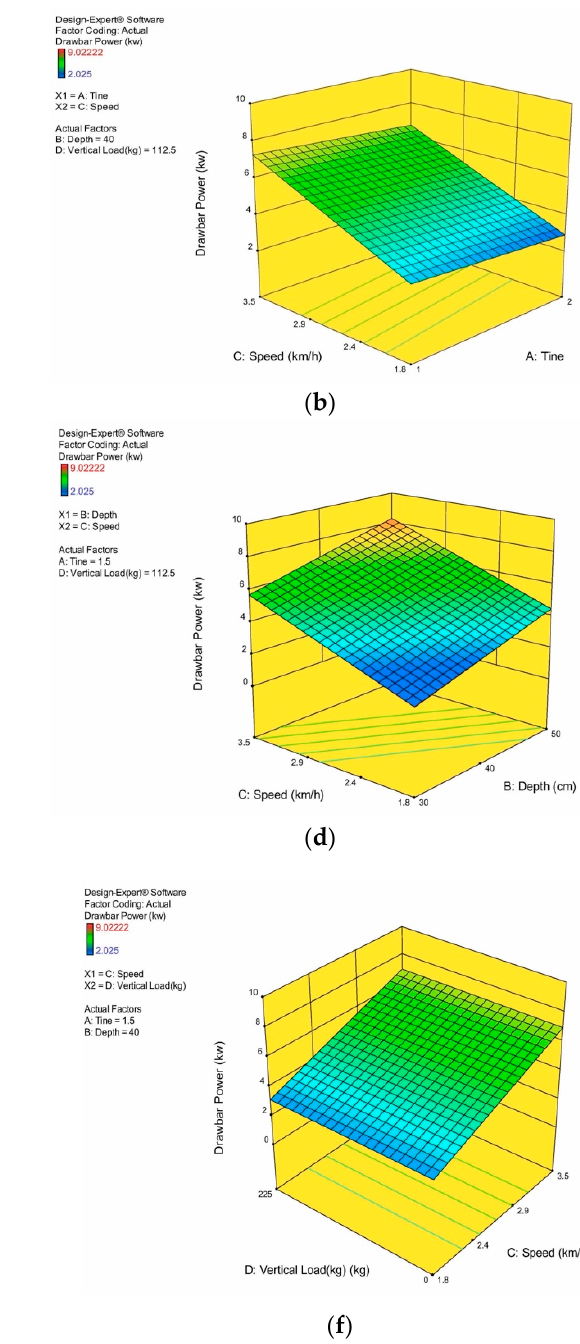
Figure 7. 3D surface curves of slippage as influenced by interactions between input parameters using the RSM approach; ( a ) tine and depth, ( b ) tine and speed, ( c ) tine and vertical load, ( d ) depth and speed, ( e ) depth and vertical load, and ( f ) speed and vertical load.